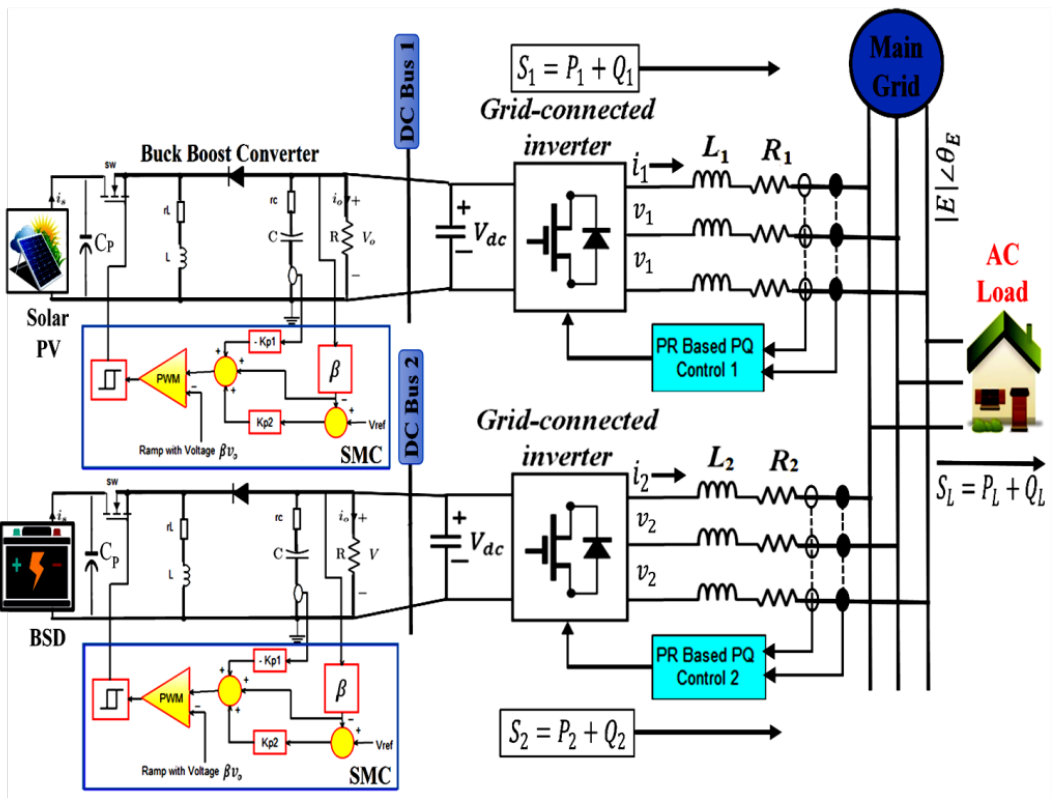
Figure 3. The two-DGs-based adopted MG system.